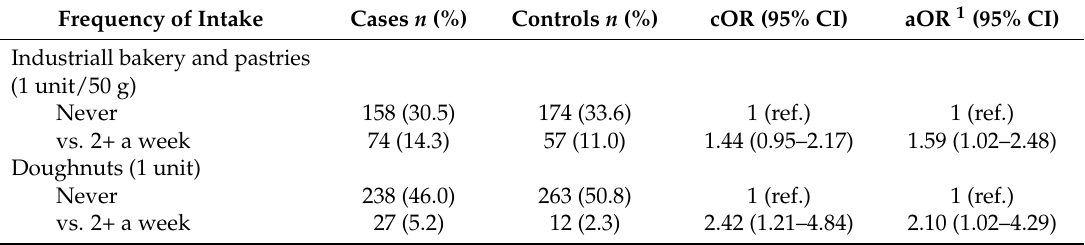
Table 4. Frequency of intake of different types of sweets and odds of SGA